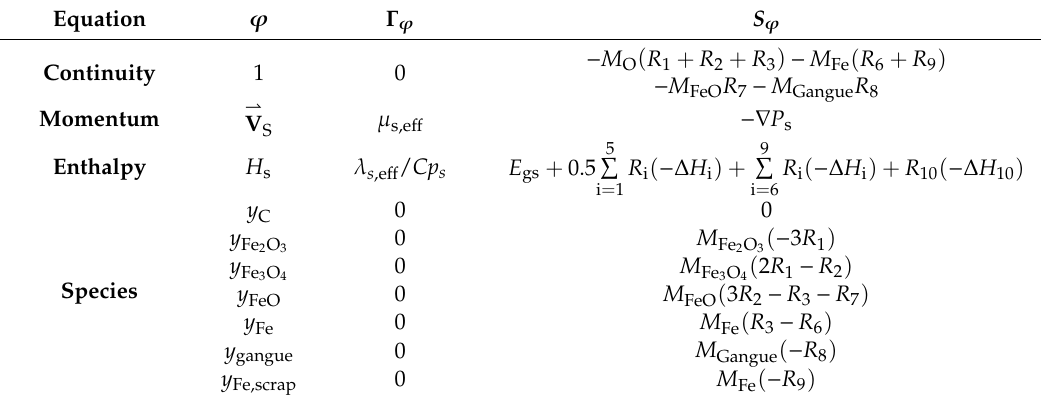
Table 6. Terms in Equation (2) for the solid